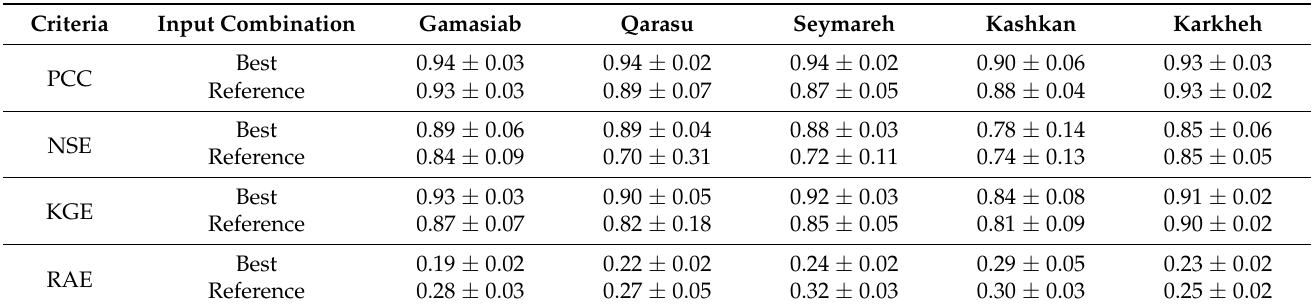
Table 10. M ± SD values of the four unitless performance criteria for the hybrid models under the best (selected) and reference combination of the input variables and max lag time for different catchments (Gamasiab, Qarasu, Seymareh, Kashkan, and